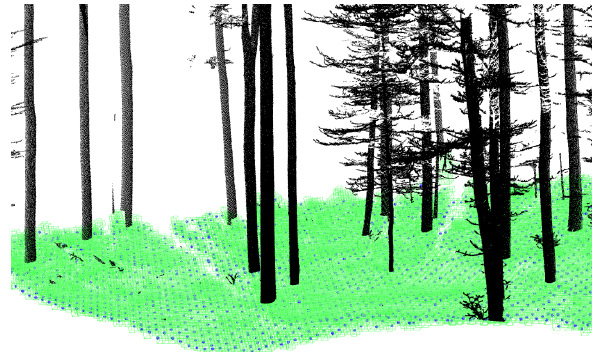
Figure 7. Detailed view of the separated point cloud with DTM points (blue dots, spacing 0.5 m) and voxels of the ground segment (green voxel, voxel size 0.2 m).